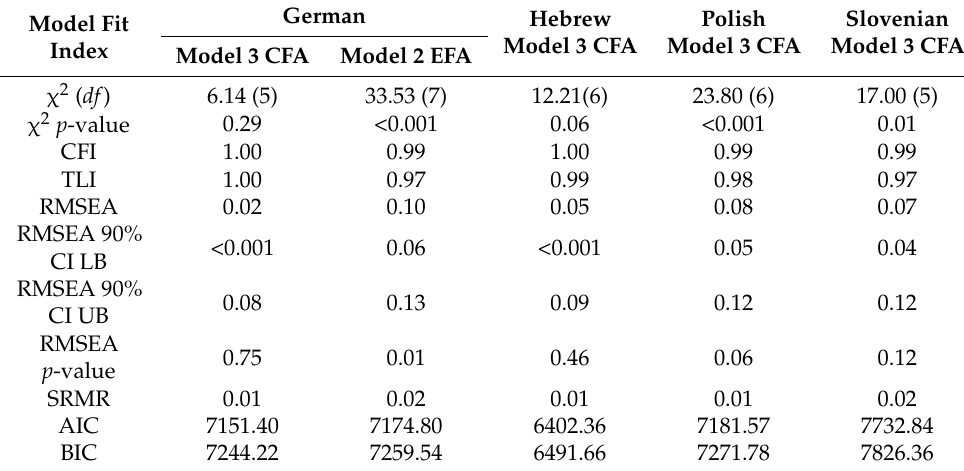
Figure 2. Model 3 plot. FoCVV = item of the Fear of Vaccination, R = error for a latent variable, e = e = error for an observed variable. error for an observed variable. Table 4. Comparison of model fit indices between four Table 4. Comparison of model fit indices between four languages.